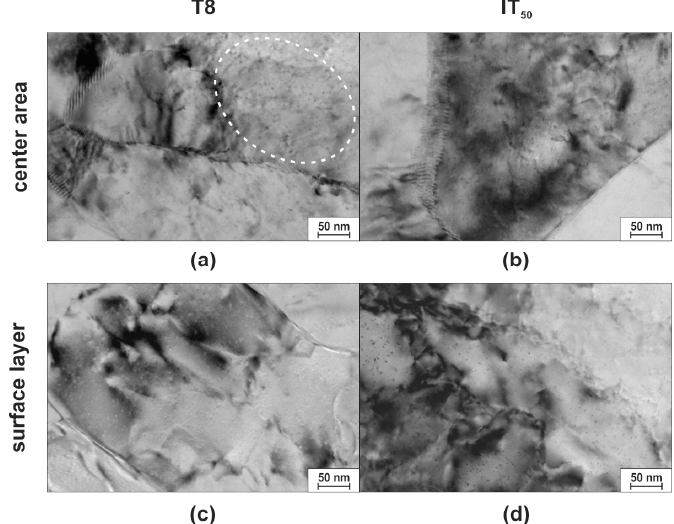
Figure 6. TEM bright-field images taken from the center areas ( a , b ) and surface layers ( c , d ) of the extruded and artificially aged material. Both conditions T8 and IT 50 exhibit very fine precipitates in the center areas as well as in the surface